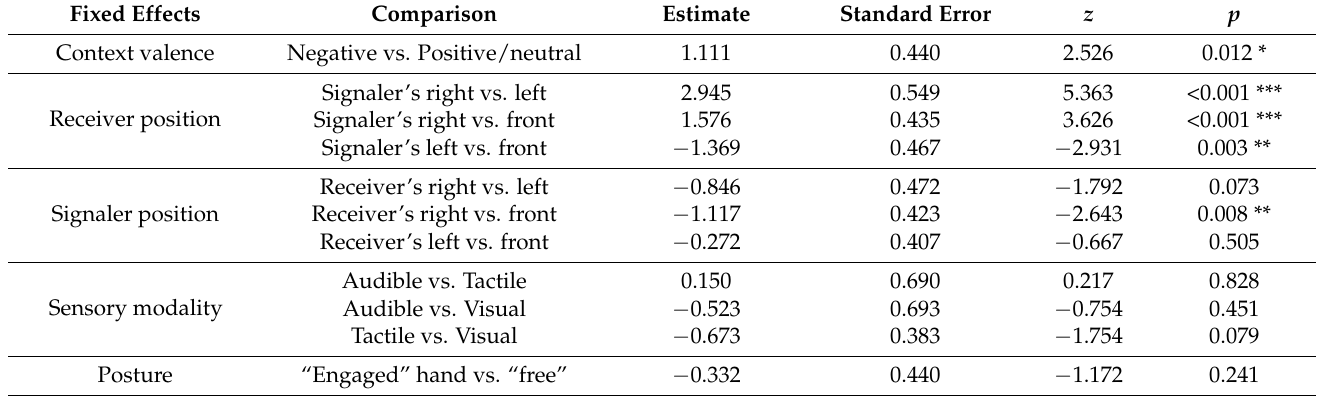
Table 4. Fixed effects of the GLMM Binomial. The first factor cited for each comparison corresponds to the reference factor. Positive values of the estimate indicate that the reference factor drives higher proportion of right-hand gestures, and conversely. *: p < 0.05; **: p < 0.01; ***: p < 0.001. Fixed